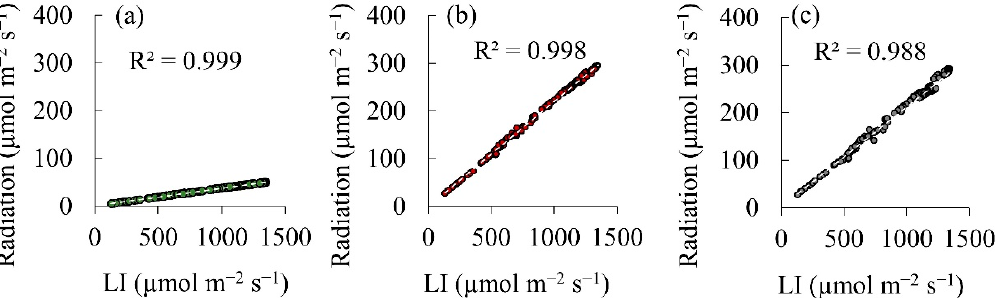
Figure A2. Spectral responses of the ( a ) green (560 nm), ( b ) red (670 nm), and ( c ) near-infrared (870 nm) wavelengths of the SpectroSense2+ multispectral radiometer to a range of photosynthetically active radiation (PAR).